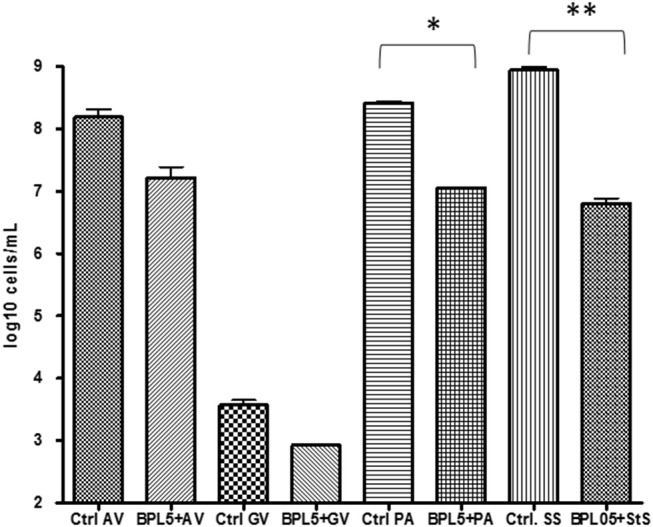
Quantification of pathogen cells in infection assays with Lactobacillus strains. *p-value < 0.05; **p-value < 0.001.